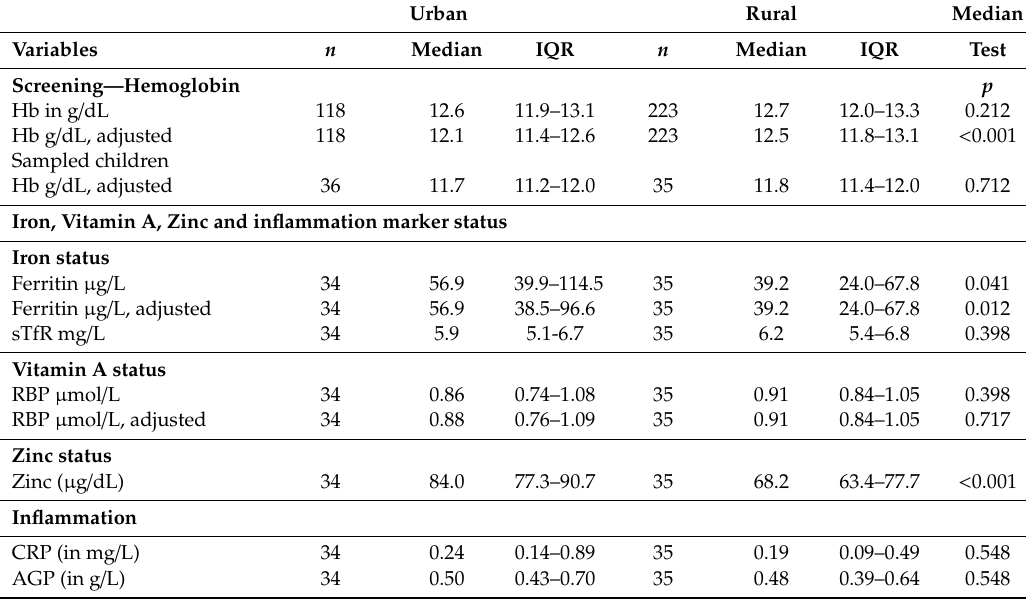
Table 5. Median and IQR of hemoglobin, iron, vitamin A, zinc status, and subclinical inflammation of